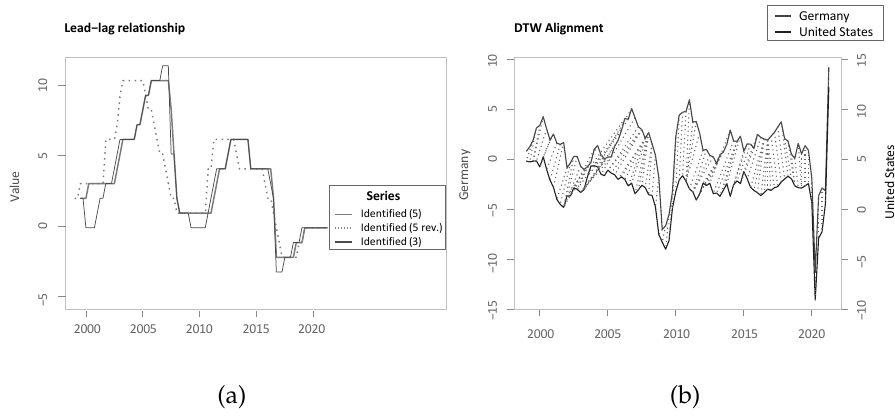
Figure 17. German and US business cycle. ( a ) lead-lag relationship; ( b )